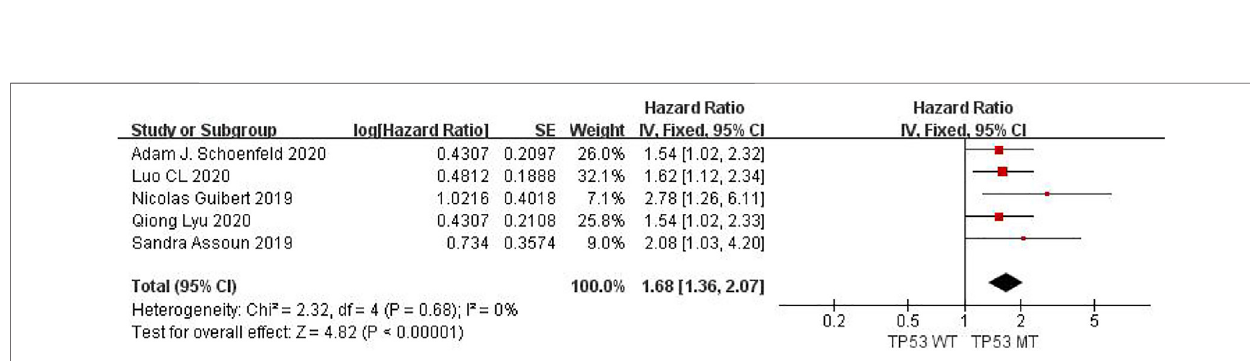
FIGURE 7 | Meta-analysis of objective responses according to TP53 status of OS in cancer patients treated with ICIs.